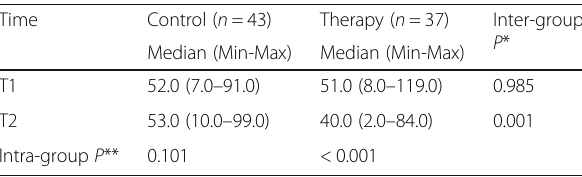
Table 3 Symptom checklist scores of SLE patients in control and therapy groups over